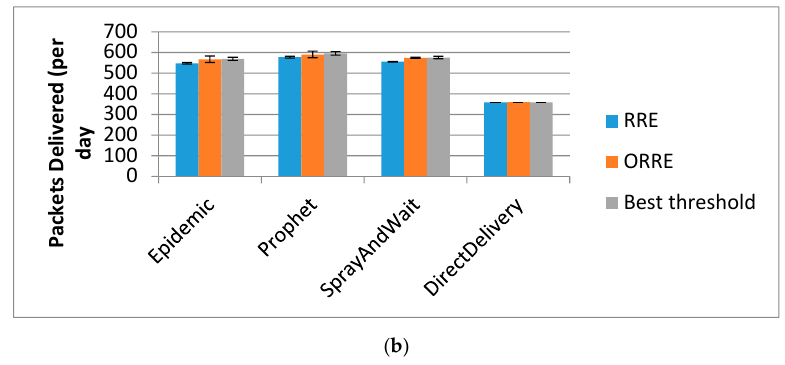
Figure 10. Variability of results across different simulation runs for ( a ) pigeon and ( b ) flying fox scenarios.